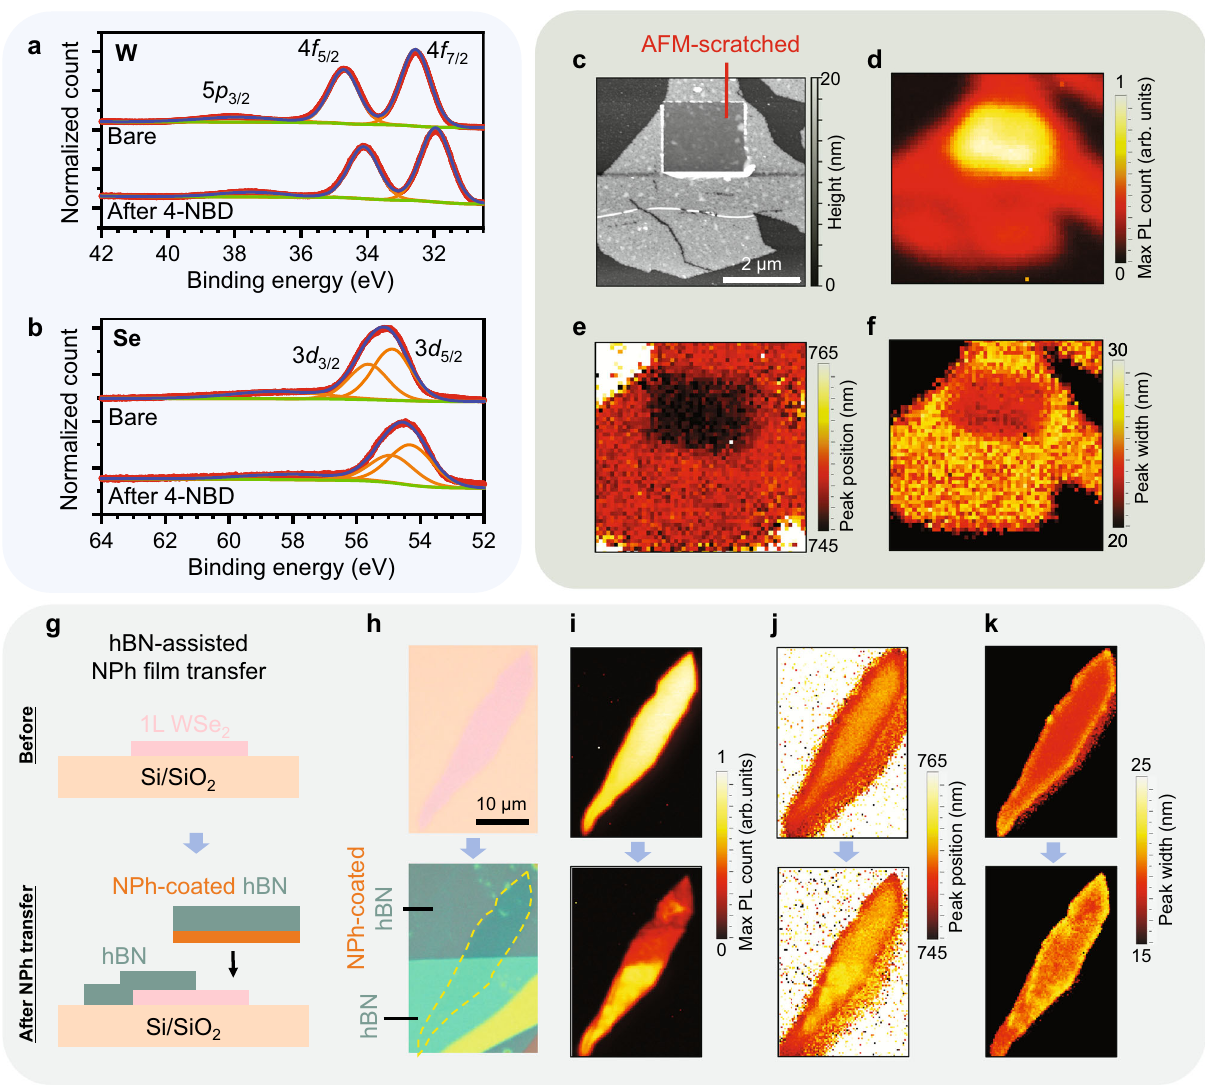
Fig. 4 | Noncovalent NPh functionalization of WSe 2 . a , b X-ray photoelectron spectroscopy (XPS) spectra of WSe 2 after 4-nitrobenzenediazonium (4-NBD) treatmentfor( a )Wand b Secore levels.Whilethechemicalshifttohigherbinding energies can be explainedby holedoping,no lineshape changes are observed that would be indicative of bond formation between WSe 2 and nitrophenyl (NPh). Red: experimental data points, orange: fi tted peaks, blue: sum of fi tted peaks, green: baseline. c – f Reversible quenching of the WSe 2 PL with AFM scratching. c Atomic